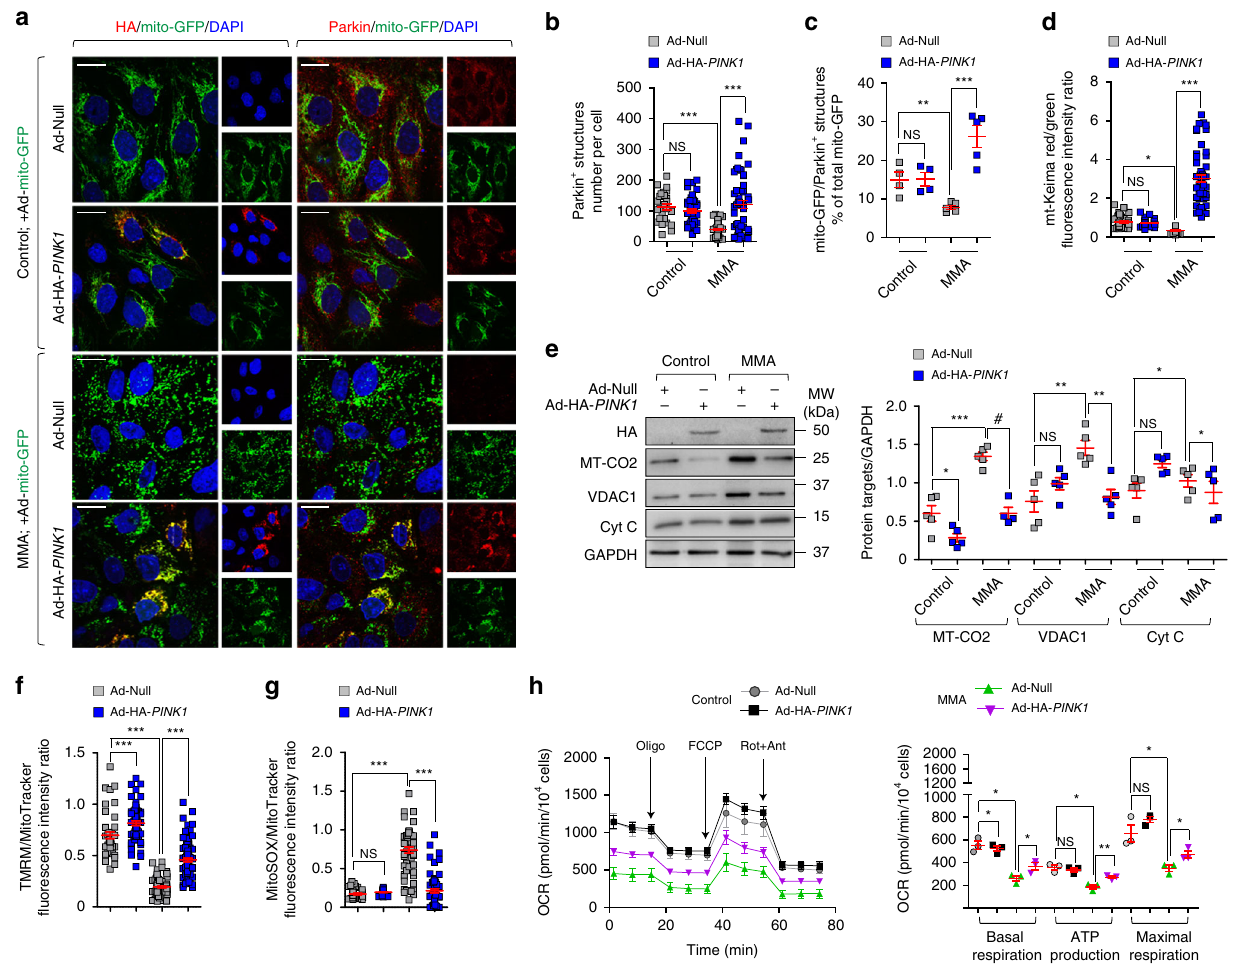
Fig. 6 Rescue of mitochondrial function and homeostasis by re-expressing PINK1 in MMA kidney cells. a – c Cells were transduced with adenovirus particles expressing mitochondrially targeted GFP (Ad-mito-GFP, green) and with adenovirus particles bearing either Null or HA- PINK1 . Cells were immunostained for HA (red) and Parkin (red). a Representative images and b quanti fi cation of numbers of Parkin + structures in a cell. Number of control cells transduced with Null ( n = 25) or HA- PINK1 ( n = 39) and MMA cells transduced with Null ( n = 57) or HA -PINK1 ( n = 55). c Quanti fi cation of mito- GFP/Parkin + structures (expressed as the percentage of total mitochondria); n ≥ 4 randomly selected and non-overlapping fi elds of views per each condition. Nuclei counterstained with DAPI (blue). d , e Null and HA- PINK1 -expressing cells were transduced with adenovirus particles bearing mt-Keima. d Confocal microscopy-based quanti fi cation of the red/green fl uorescence intensity ratio in a cell. Number of control cells transduced with Null ( n = 46) or HA- PINK1 ( n = 38) and MMA cells transduced with Null ( n = 51) or HA − PINK1 ( n = 54). e Representative immunoblotting and quanti fi cation of the indicated mitochondrial proteins; n = 5 biologically independent experiments. f , g Cells were loaded with ( f ) TMRM (green) or ( g ) MitoSOX (green) and MitoTracker (red), and analysed by confocal microscopy. Quanti fi cation of TMRM/MitoTracker or MitoSOX/MitoTracker fl uorescence intensity ratio in a cell. Number of control cells transduced with Null ( n = 43) or HA- PINK1 ( n = 62) and MMA cells transduced with Null ( n = 83) or HA- PINK1 ( n = 84) for TMRM/MitoTracker. Number of control cells transduced with Null ( n = 38) or HA- PINK1 ( n = 56) and MMA cells transduced with Null ( n = 59) or HA- PINK1 ( n = 64) for MitoSOX/MitoTracker. h Oxygen consumption rate (OCR) and individual parameters for basal respiration, ATP production and maximal respiration. OCRs were measured at baseline and after the sequential addition of Oligomycin (Oligo, 1 μ M), FCCP (0.5 μ M) and Rotenone (Rot; 1 μ M) + Antimycin A (Ant; 1 μ M). Values in a – h are pooled from three biologically independent experiments. Plots represent mean ± SEM. One-way ANOVA followed by Bonferroni ’ s post hoc test, * P < 0.05 and *** P < 0.001 relative to control or MMA cells transduced with Null in b , d , f and g . Two-tailed Student ’ s t -test, * P < 0.05, ** P < 0.01, *** P < 0.001 and # P < 0.0001 relative to control and MMA cells transduced with Null in c , e and h . Scale bars,10 μ m. NS non-signi fi cant. Source data are provided as a Source Data fi